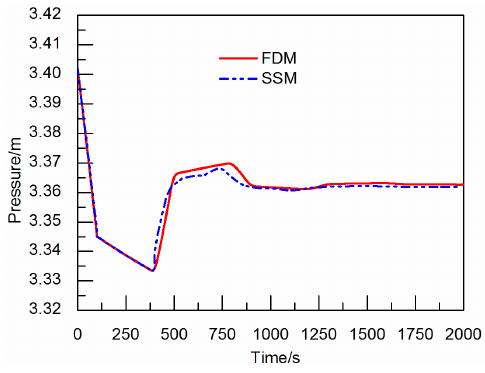
Figure 2. Method verification of the open channel model.